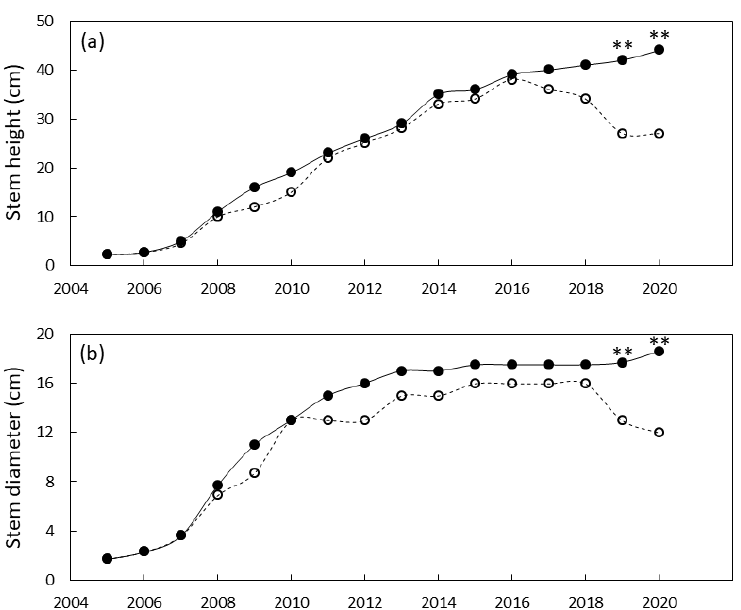
Figure 7. Size of Cycas micronesica plants growing in a north Guam garden over a 15 y growth pe- riod. ( a ) leaf number and ( b ) maximum leaf length. Closed circles are local genotypes, open circles are foreign genotypes. ** = significant at p ≤ 0.01.